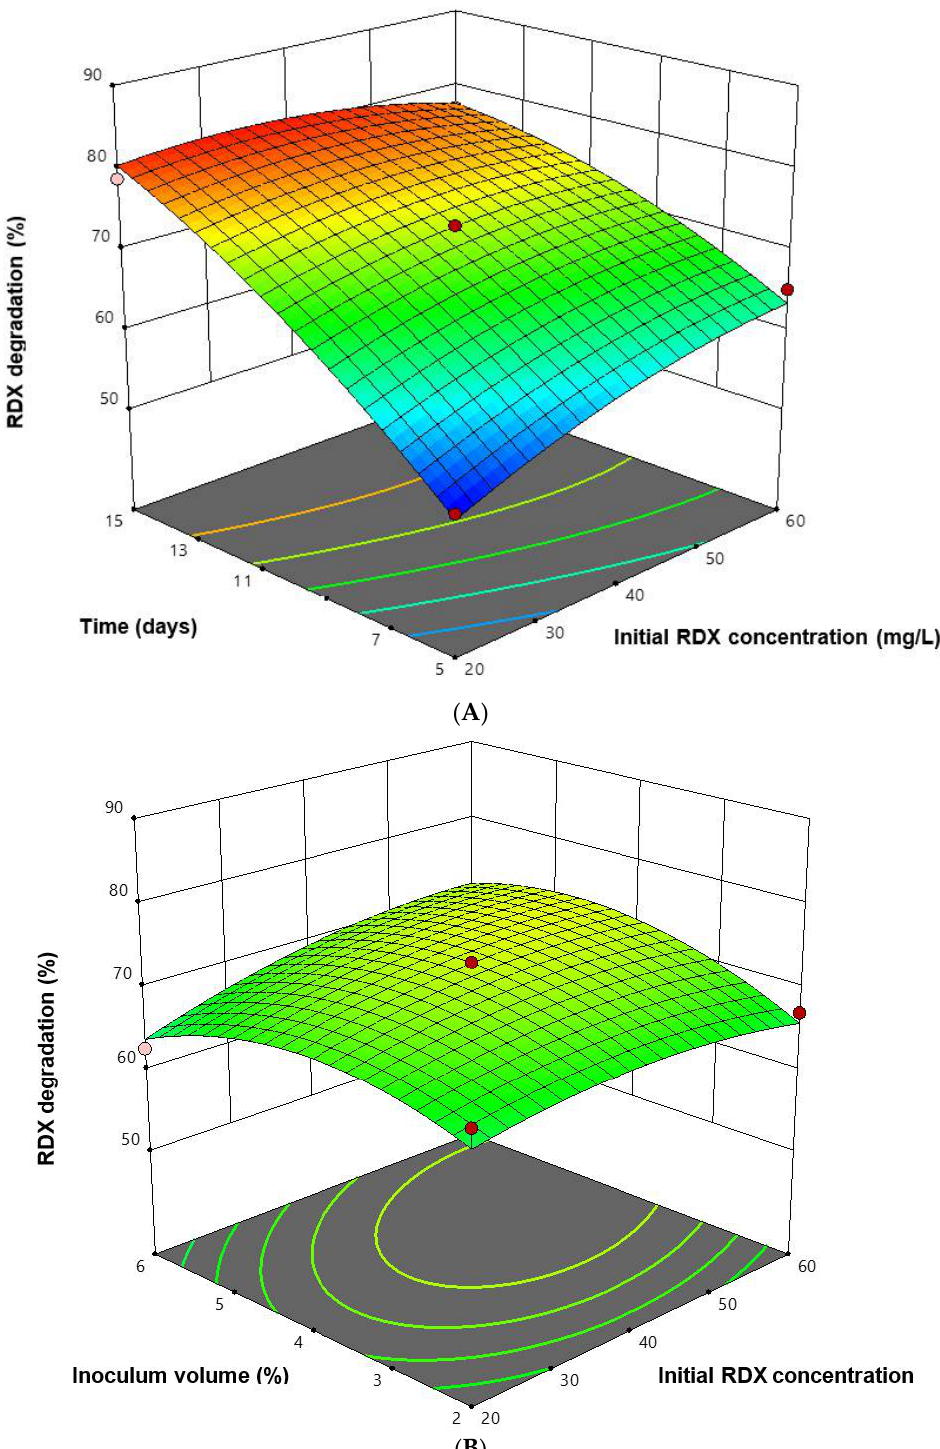
Figure 1. ( A ) 3-D model plot for the degradation of RDX under varying initial concentration (mg/L) and time (days) with Bacillus toyonensis . ( B ) 3-D model plot for the degradation of RDX under varying initial concentration (mg/L) and inoculum volume (%) with Bacillus toyonensis